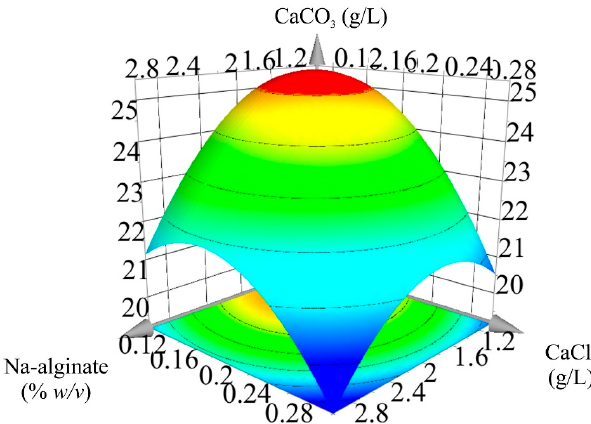
Figure 3. 3D response surface plot showing the interactive effects of Na-alginate and CaCl 2 for bacterially induced CaCO 3 precipitation. To investigate the optimum levels of variables on the biosynthesis process, RSM, using a CCF design matrix, was used. The statistical analysis data containing the regression coefficients for the model are given in Table 2. As shown in Equation (2), a quadratic model was regressed for predicting the CaCO 3 precipitation.